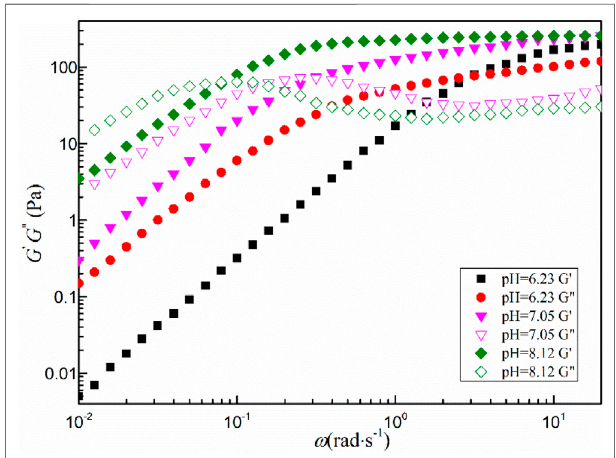
Frontiers in Chemistry |